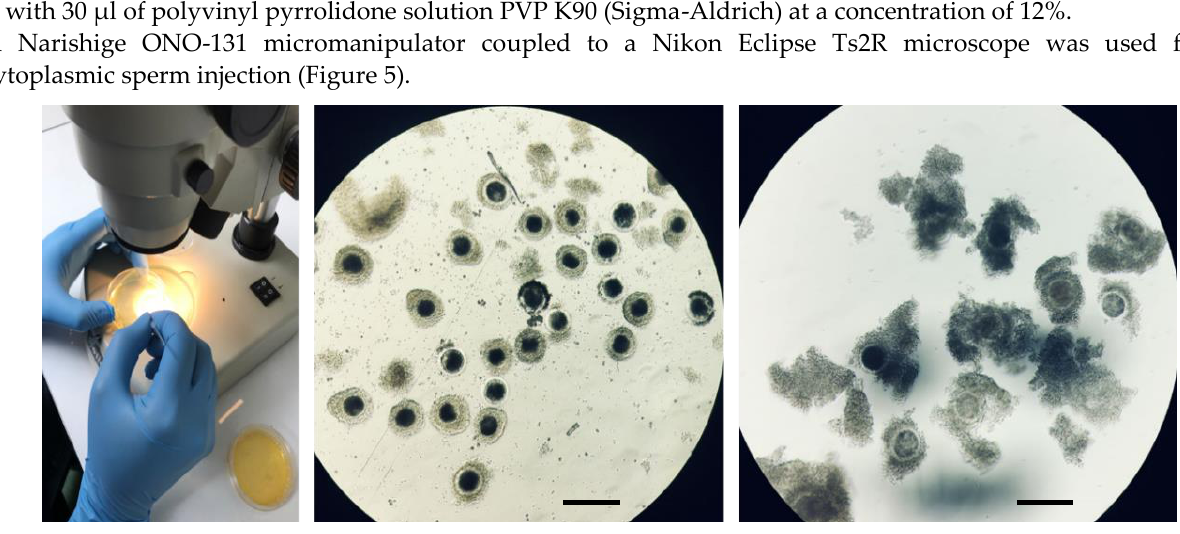
Figure 2 . Morphological evaluation of cumulus-oocyte complexes (bar = 200µm).